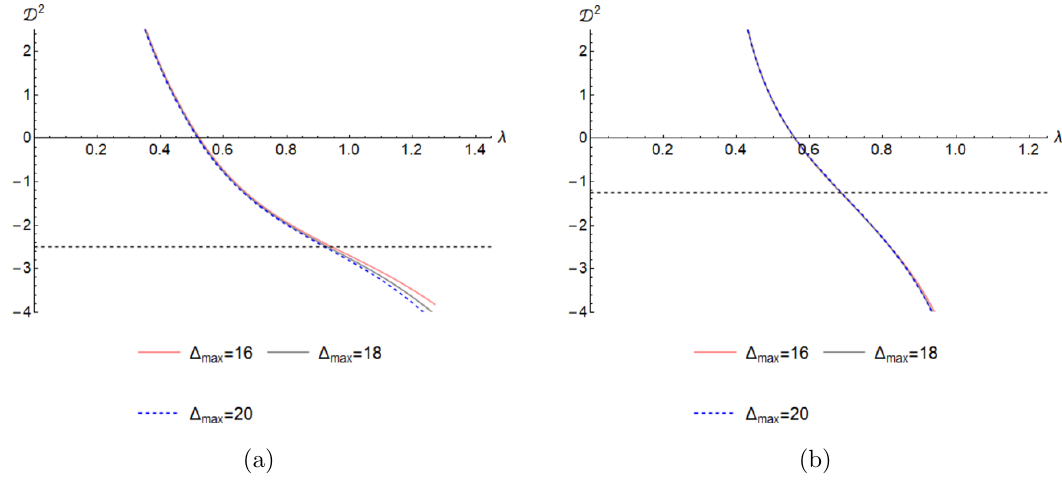
Figure 11. (a) D 2 ( e 2 (cid:0) e 0 ) versus (cid:21) > 0 in the TIM with (d) spectator boundary condition; (b) D 2 ( e 2 (cid:0) e 0 ) versus (cid:21) < 0 in the TIM with (d) spectator boundary